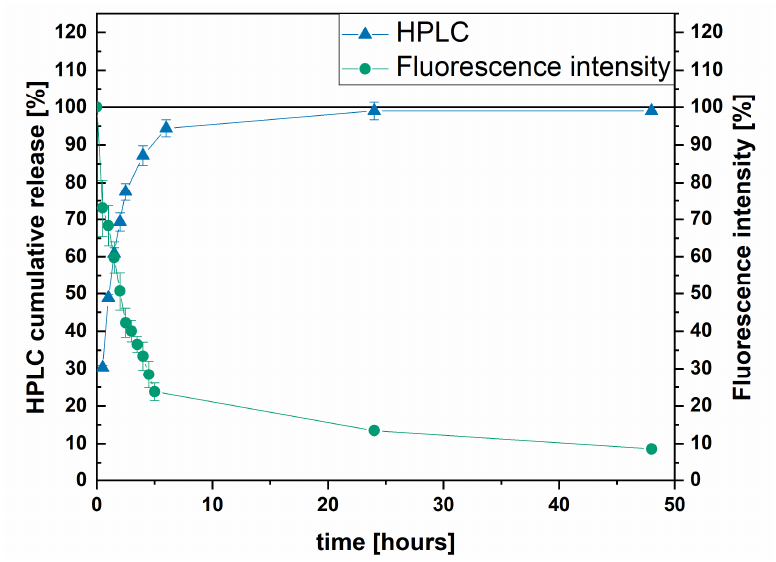
Figure 8. Release of siRNA-Cy3 measured by fluorescence imaging and